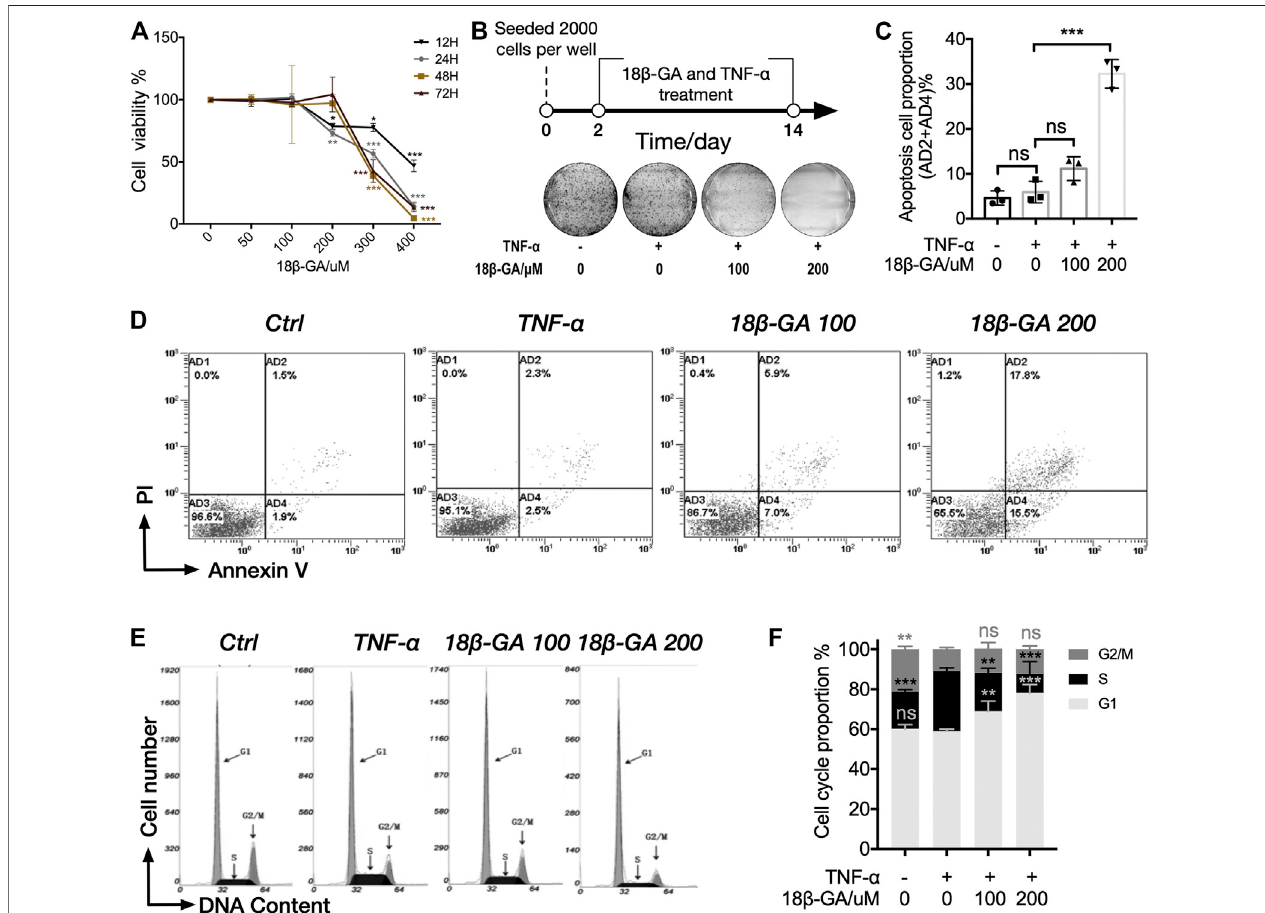
FIGURE2| 18 β -GAsuppressescellproliferationthroughinducingcellapoptosisand cellcyclearrest. (A) MH7A cellsweretreatedwithgradients of18 β -GAalong with100 ng/mlTNF- α fordifferenttime periods (12 – 48 h),and cellviabilitywasdetected bytheMTSassay.Signi fi cance wasdeterminedbyusingtwo-way ANOVA with Tukeytesting, and errorbars indicate SD. * p < 0.05; ** p < 0.01; *** p < 0.001, n (cid:2) 3. (B) The colony formation assay wasperformed for thedetermination of cytotoxicity of 18 β -GA. A simpli fi ed work fl ow and representative result are shown ( n (cid:2) 3). (C) Quanti fi cation of the data in D. Sum of AD2 and AD4 is calculated and presented in the graph.One-way ANOVA with Tukey test isapplied forstatistical analysis, error bars indicate SD, and ns means no signi fi cant change; *** p < 0.001, n (cid:2) 3. (D) The cell apoptosis assay is stained with PI and Annexin V and measured by fl ow cytometry. Representative fl ow cytometry plots are shown ( n (cid:2) 3). (E) Representative histogram of MH7A cells stained with nuclear dye showing DNA content distribution. G1, S, and G2/M peaks are highlighted by arrow. (F) Quanti fi cation result of the cell cycle assay. Data show mean ± SD, as comparing with TNF- α stimulation, and ns means no signi fi cant change; ** p < 0.01; *** p < 0.001, n (cid:2) 3.